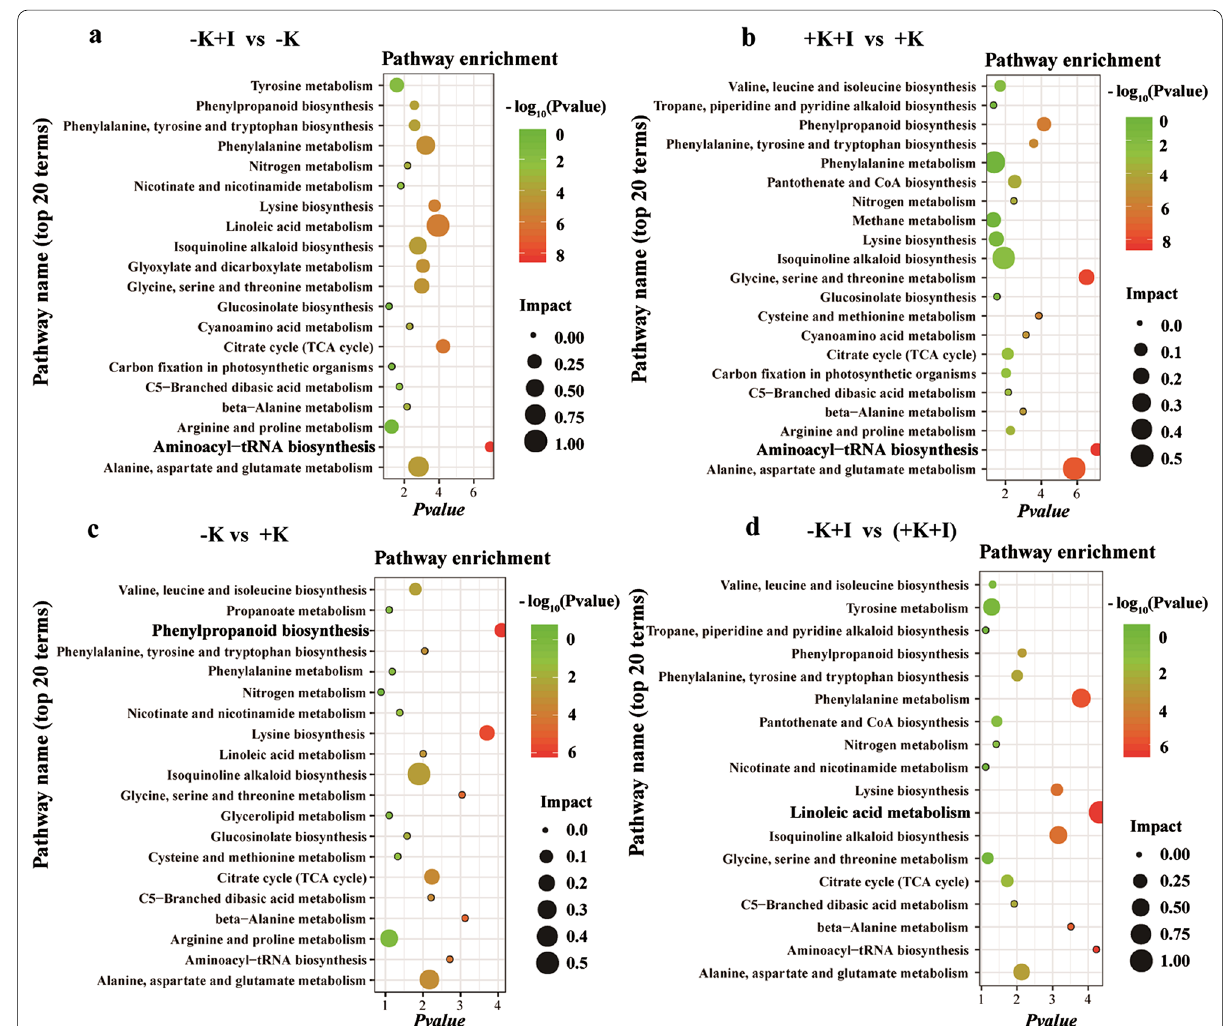
Fig. 4 KEGG enrichment analysis of metabolites altered by S. oryzae infection. a The aminoacyl-tRNA biosynthesis pathway was dramatically enriched in K-starved plants after infection. b The aminoacyl-tRNA biosynthesis pathway was dramatically enriched in K-sufficient plants after infection. c The phenylpropanoid biosynthesis pathway was significantly enriched in K-starved plants versus K-sufficient plants before inoculation. d The linoleic acid metabolism pathway was dramatically enriched in K-starved plants versus K-sufficient plants upon S. oryzae infection. Orthogonal partial least squares discriminant analysis was used to evaluate the variable importance on the projection (size of the solid circle), and Student’s t-test ( p -value < 0.05 denotes significance) was used to analyze the abundance of the metabolites. The color of the circle represents the ( p